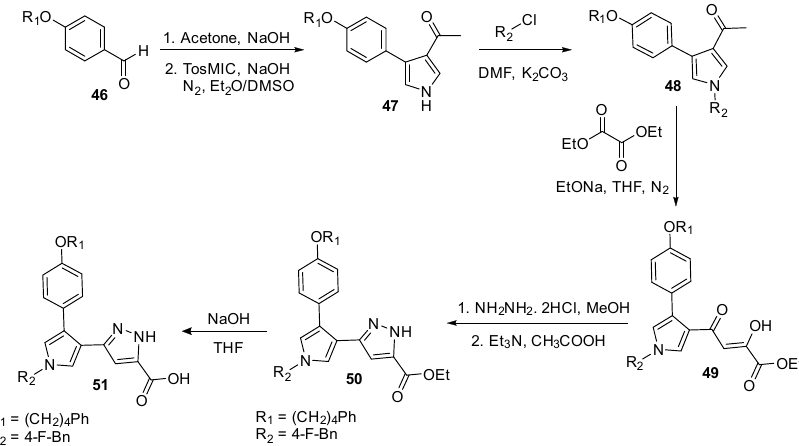
Scheme 11. Synthesis of inhibitors against HIV-1 RNase H.